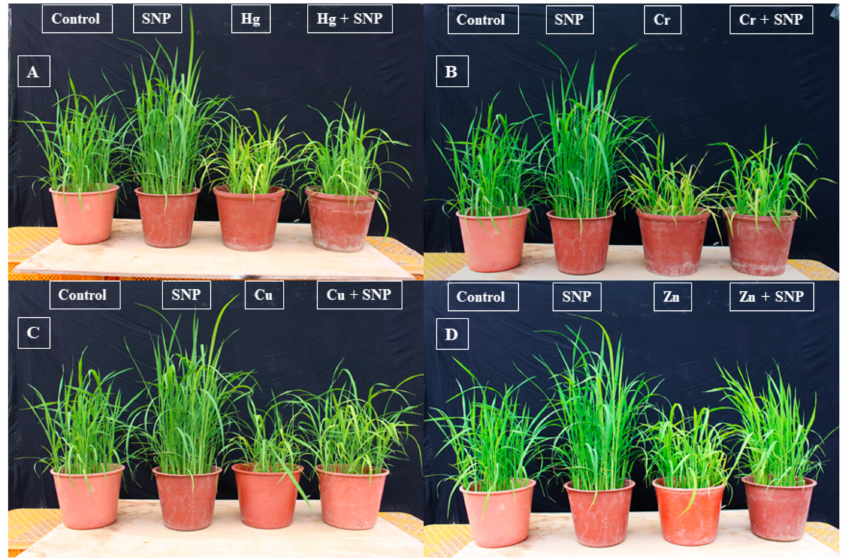
Figure 1. Effects of exogenously applied SNP on rice vigor with or without Hg-, Cr-, Cu-, and Zn-induced stress. ( A ) Control, SNP, Hg, Hg + SNP, ( B ) Control, SNP, Cr, Cr + SNP, ( C ) Control, SNP, Cu, Cu + SNP, ( D ) Control, SNP, Zn, Zn +